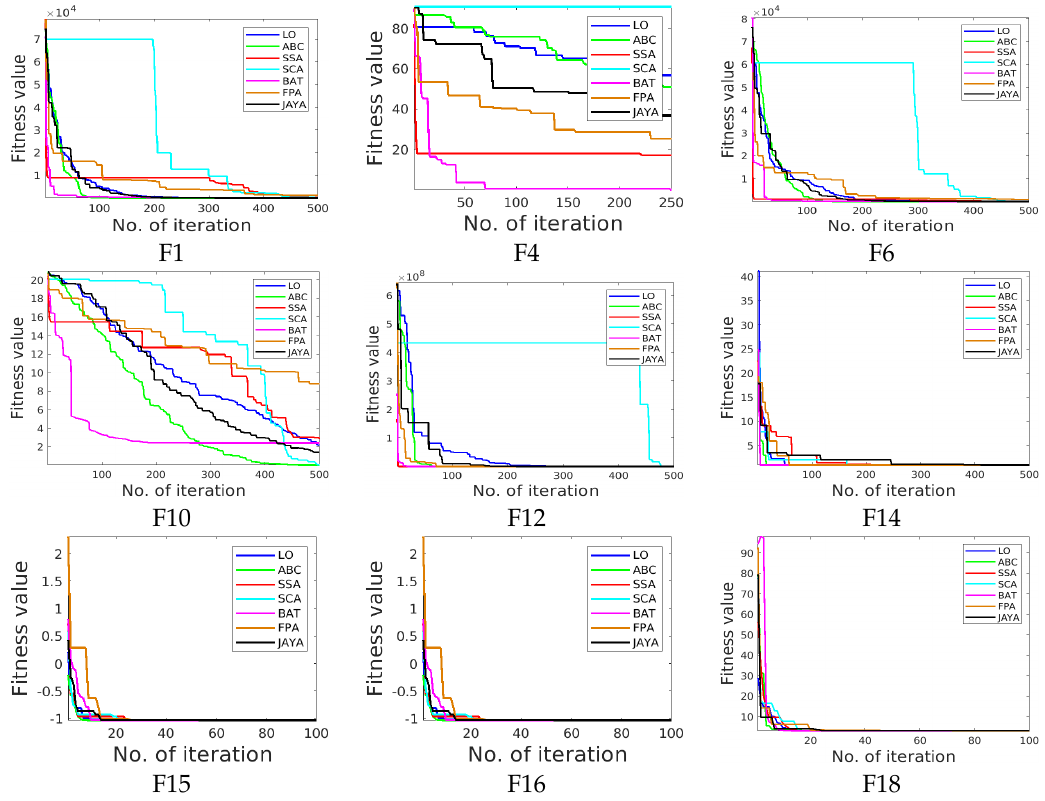
Figure 7. LO algorithm convergence plots with the other swarm − based